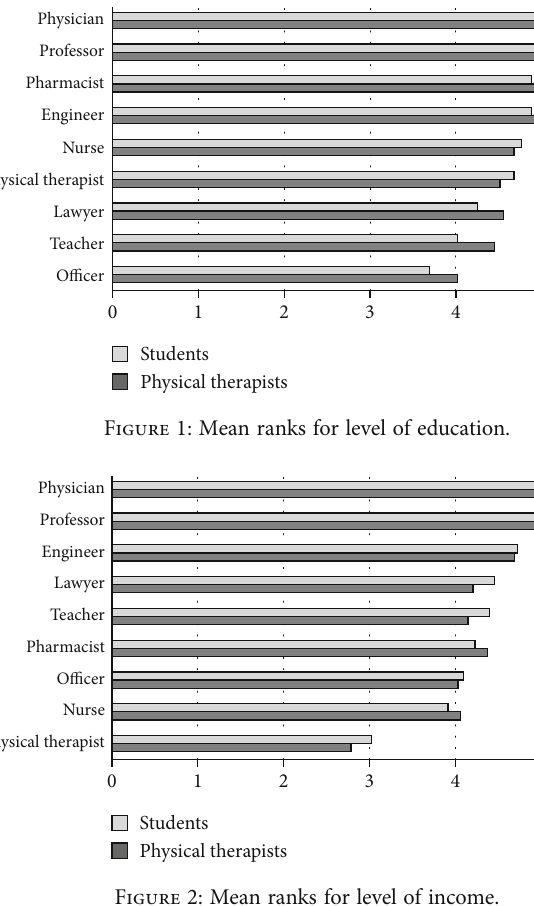
Figure 2: Mean ranks for level of income.